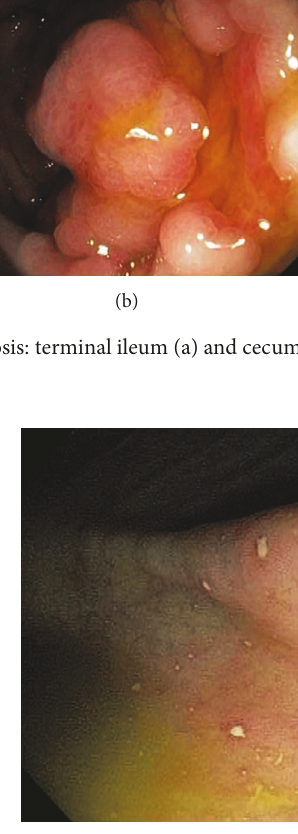
Figure 29: Endoscopic image of eosinophilic colitis showing patchy erythema with erosions.